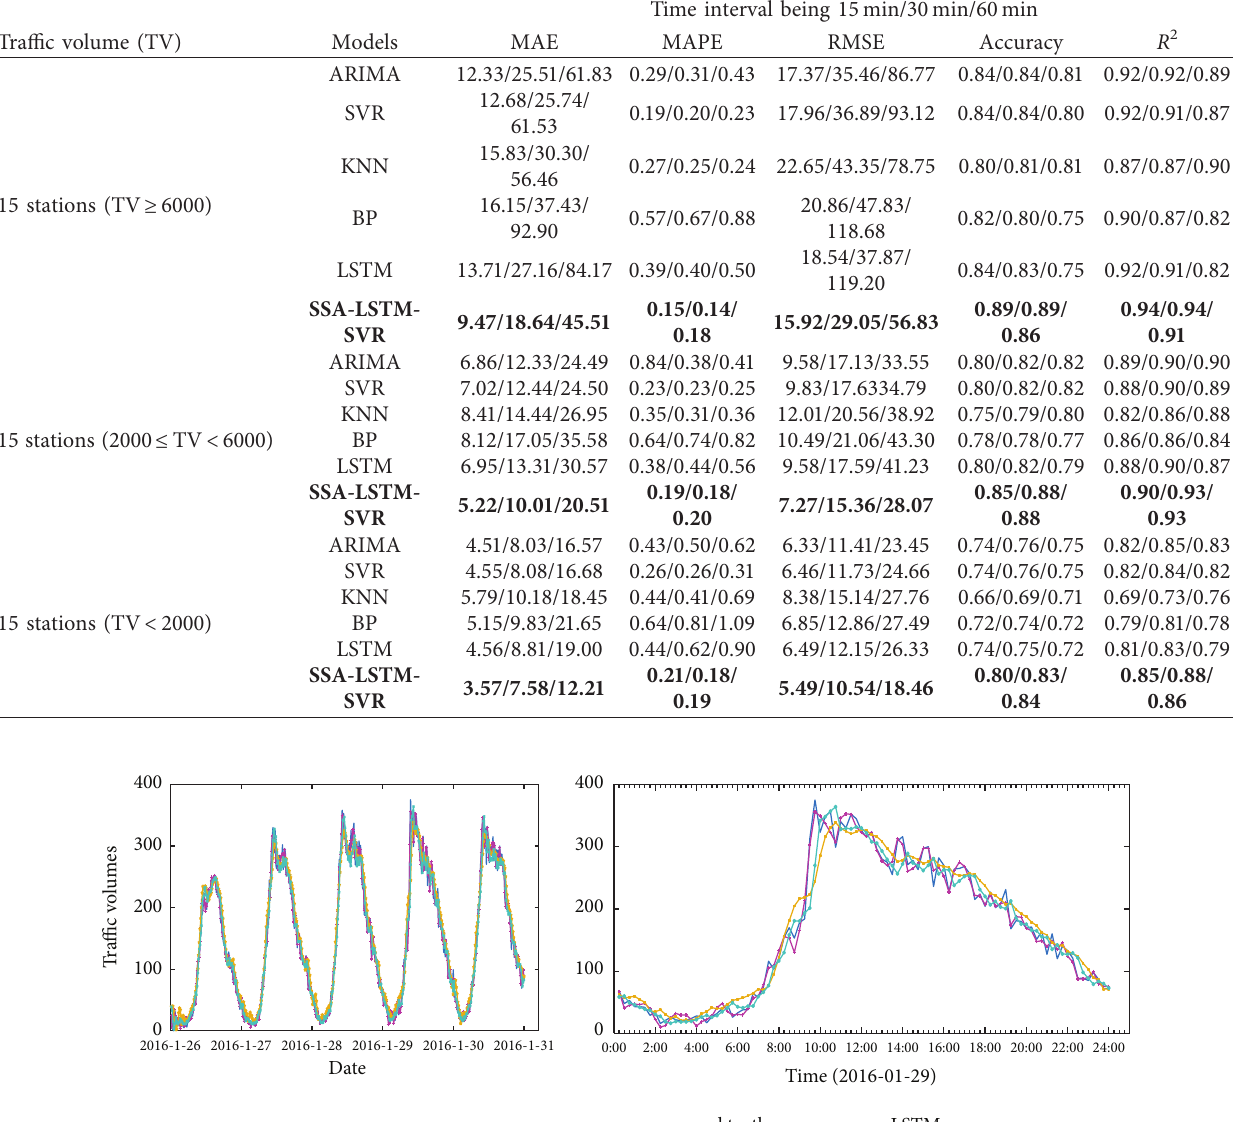
Table 2: The performance of different methods on Guiyang City Road Toll Stations.